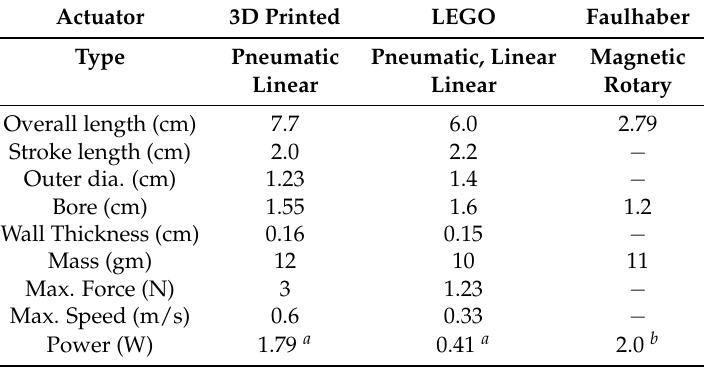
Figure 10. Force generated by the actuator on the constrained rail experiment: ( a , c ) results for LEGO actuator and ( b , d ) results for 3D printed actuator. Also, ( a , b ) are for the same input pressure of 20 psi or 137.5 kPa and ( c , d ) are for the same input pressure of 40 psi or 275 kPa. Table 1. Comparing three actuators: 3D printed pneumatic actuator, LEGO pneumatic actuator, and Faulhaber DC